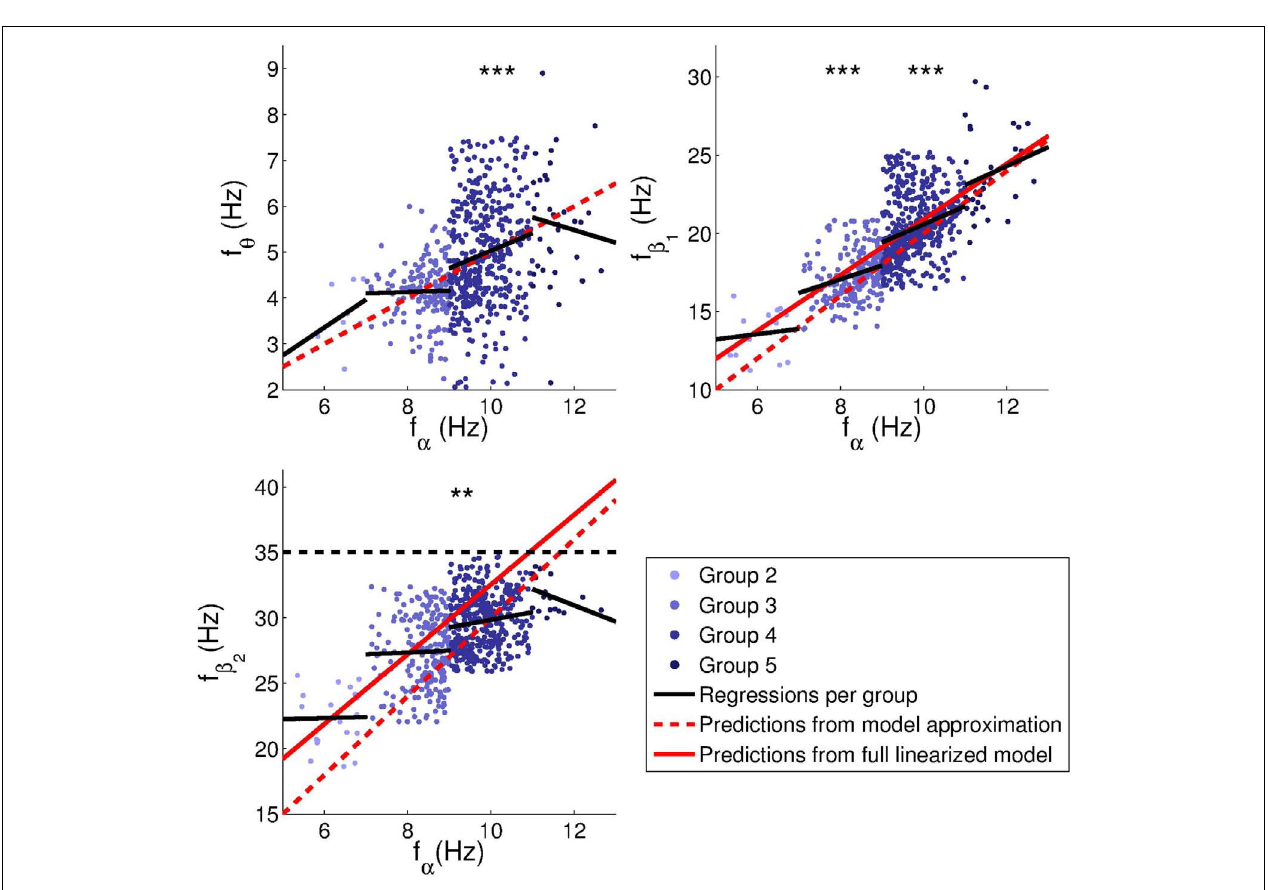
predictions based on the approximations in Section 2.2 ( f θ = f α /2, = 2 f α , f β = 3 f α ); continuous red lines linear fits with intercepts f β 1 2 based on fitted model spectra from Section 3.1.The dashed black line is a reminder that no peaks were fitted above 35Hz. Significance levels: **0.01,